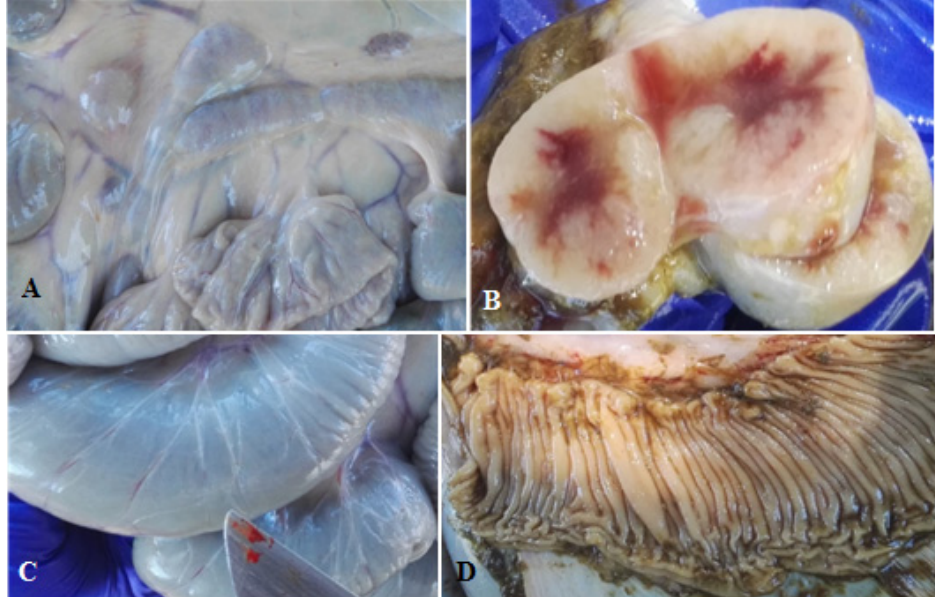
Figure 1. Findings observed after post-mortem examination of the calves. ( A ) Moderately enlarged mesenteric lymph nodes. Calf #050917, group A; ( B ) mesenteric lymph node with marked prolifer- ation of cortical lymphoid tissue. Calf #300917, group A; ( C ) dilatation and signs of lymphangitis on the serosa of the ileum. Calf #300917, group A; and ( D ) folding of the ileal mucosa. Calf #011017, group A.